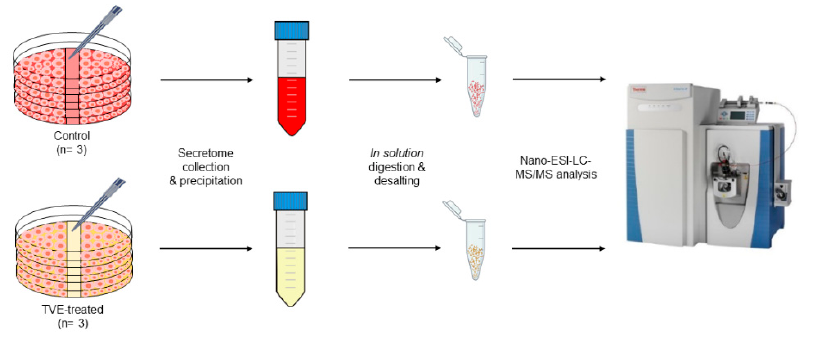
Figure 1. Experimental workflow.